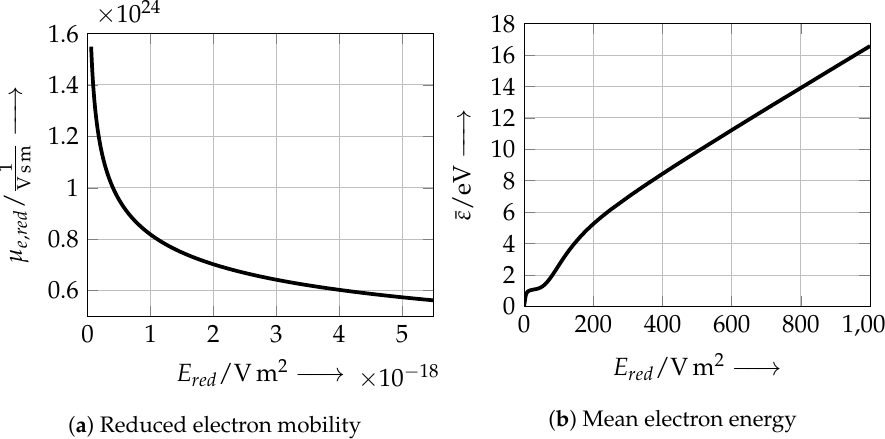
Figure 3. Reduced electron mobility and mean electron energy as a function of reduced field strength according to